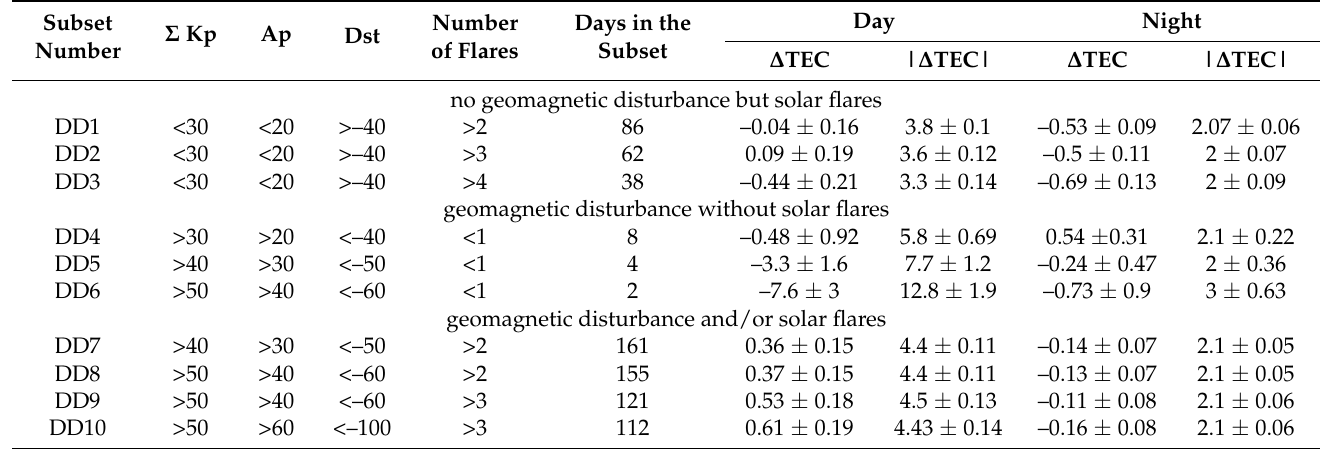
Table 10. Parameters of the subsets of DDs and the mean ∆ TEC (in TECu) values. Data are for the PCA-MRM model with L = 31 days and averaging the model with lag = 1 day and lag = 2 days.